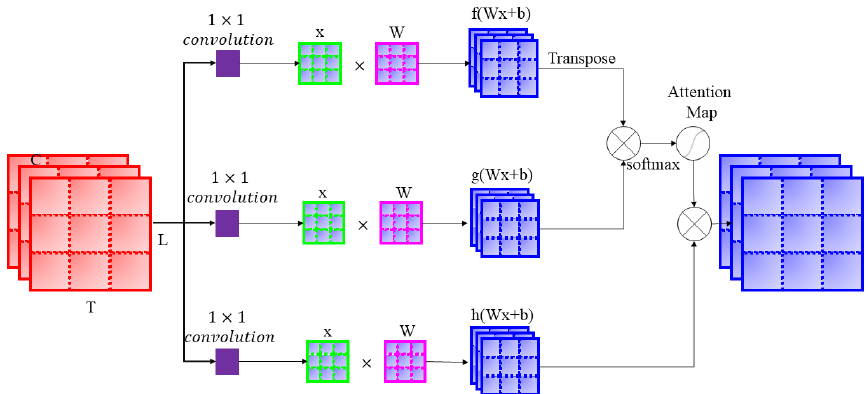
Figure 5. Attention block.